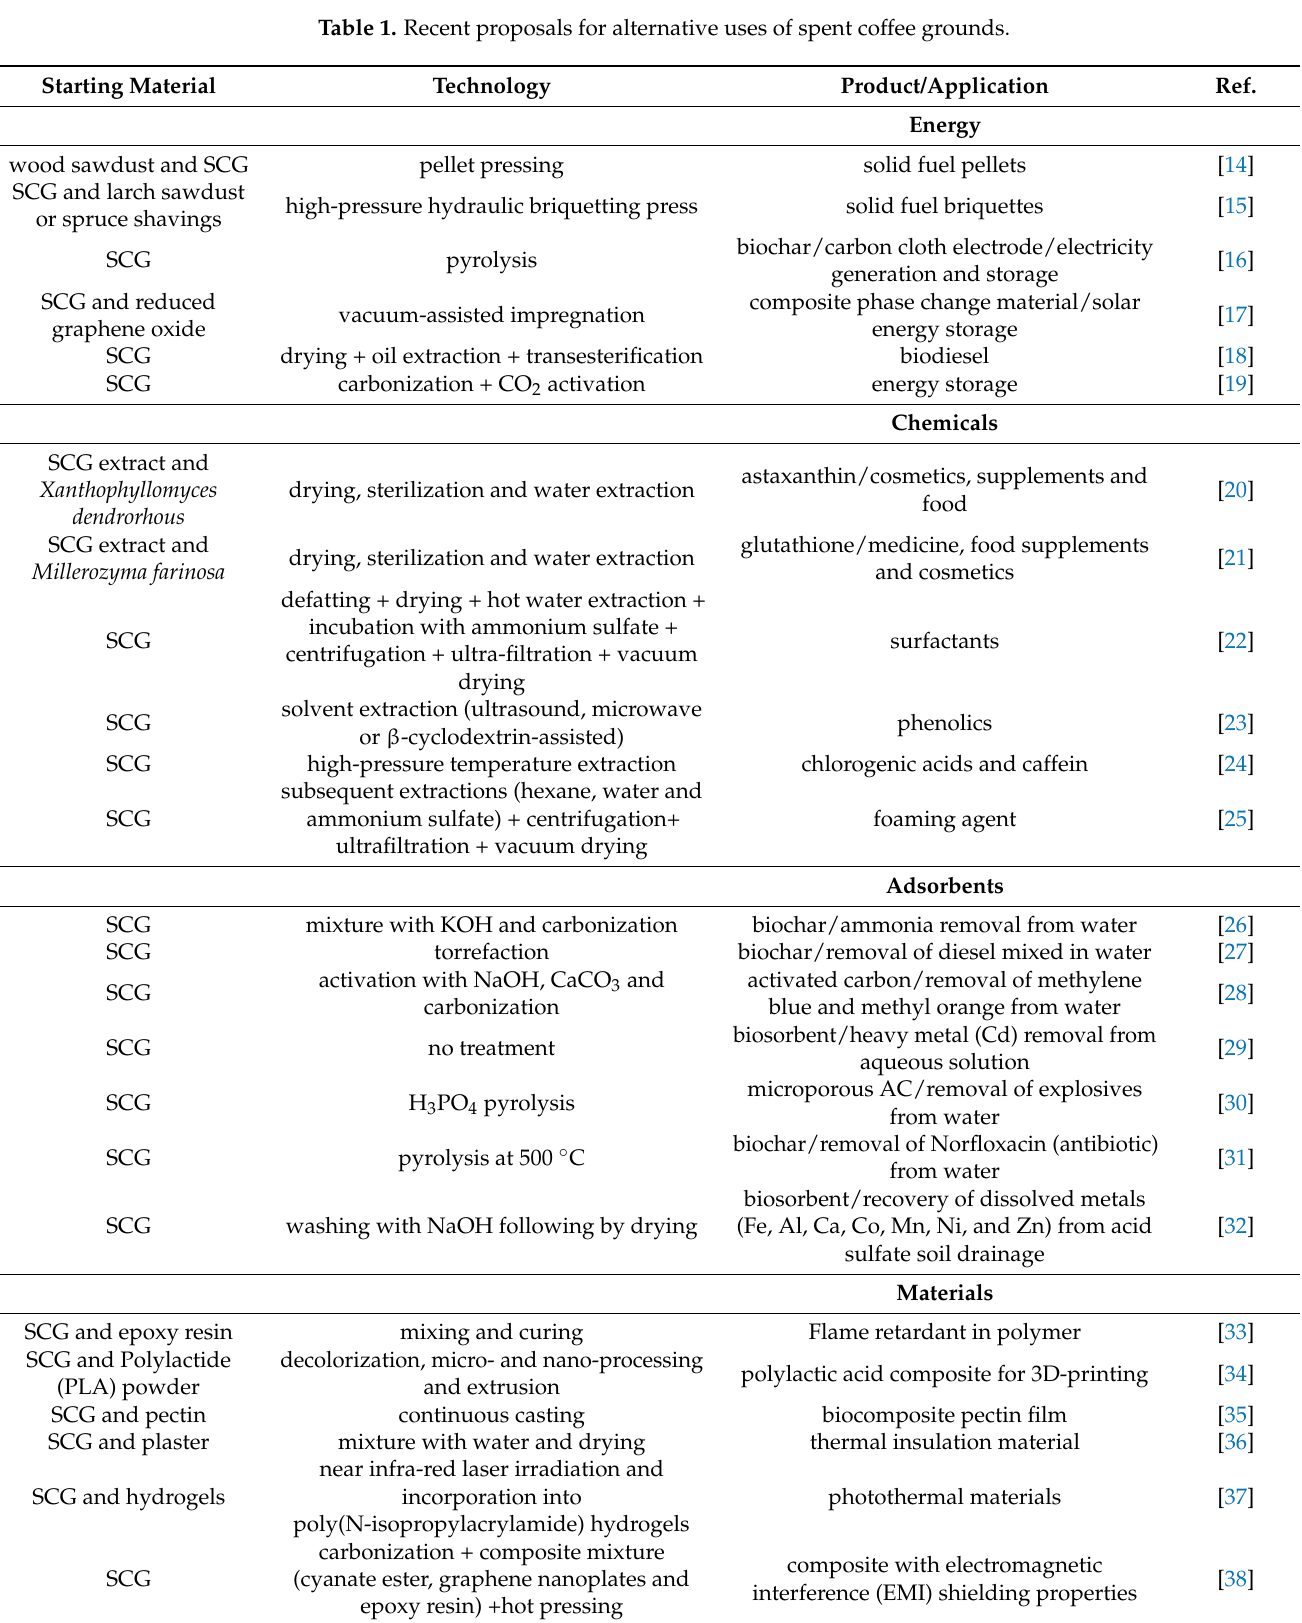
Table 1. Recent proposals for alternative uses of spent coffee